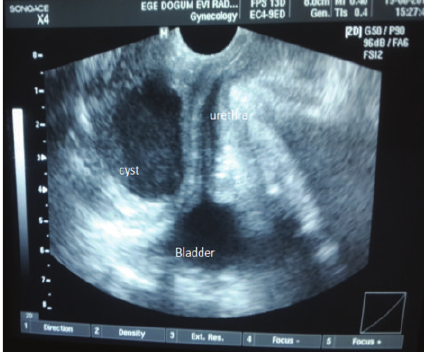
Figure 2: Perineal ultrasonography revealed no relationship between the cyst and the lower urinary tract.